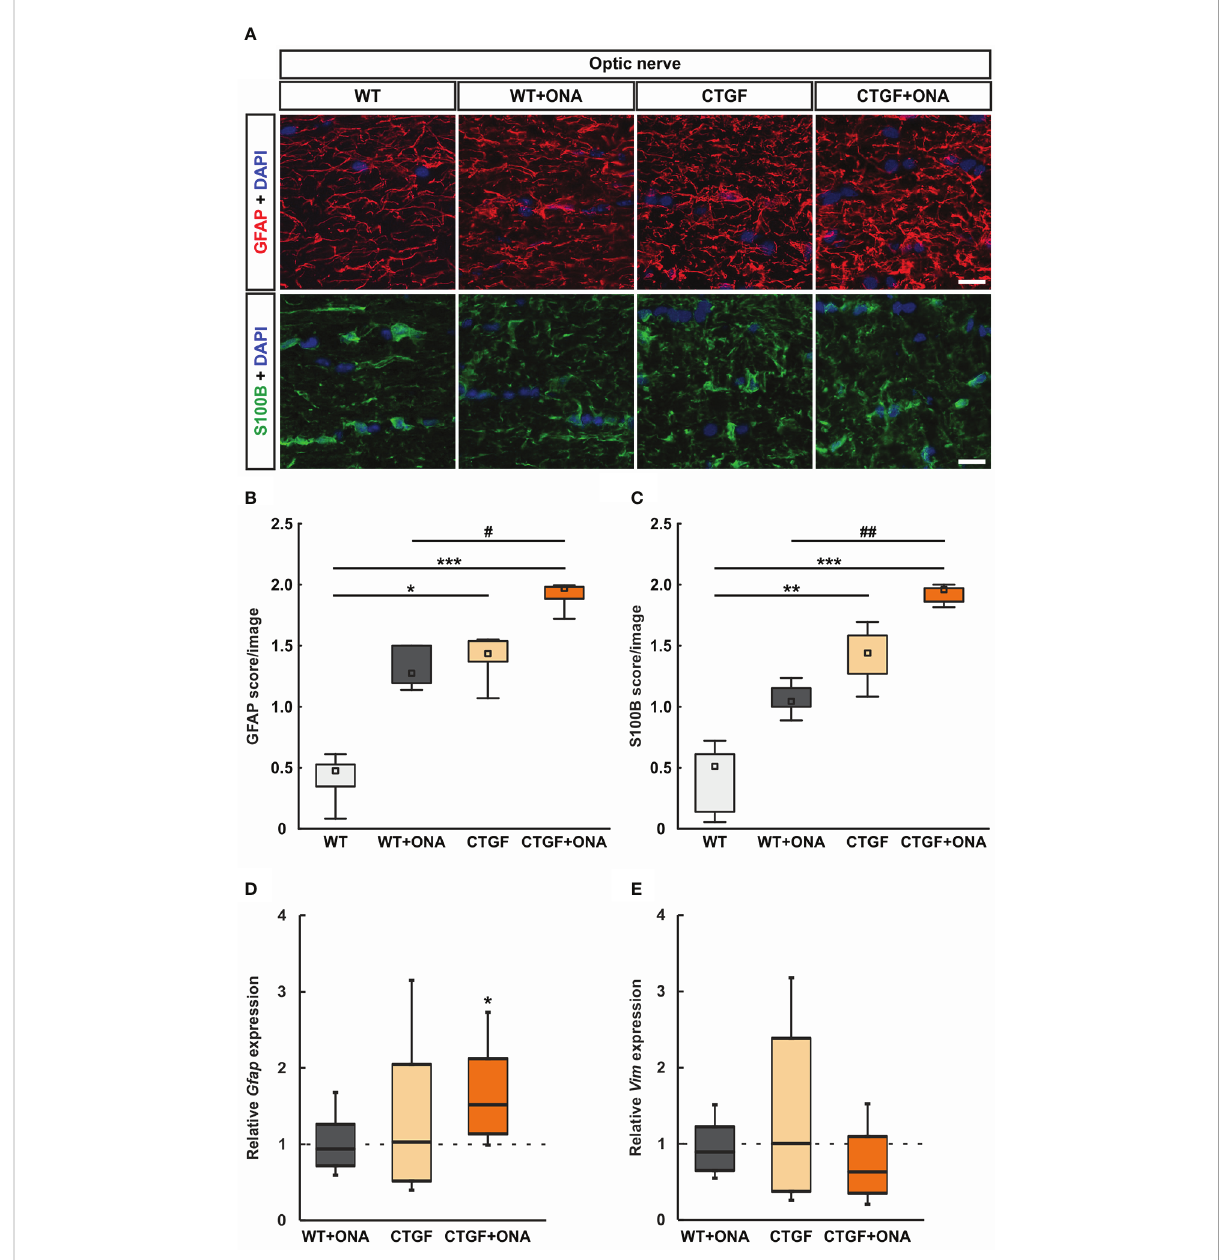
FIGURE 4 Increased astrogliosis in CTGF+ONA optic nerves. (A) Longitudinal optic nerve sections were stained with antibodies against anti-GFAP (red) and anti- S100B (green) to label astrocytes. DAPI was used to counterstain cell nuclei (blue). (B) The GFAP score was not altered in WT+ONA optic nerves compared to WT. A higher score was revealed in CTGF and CTGF+ONA optic nerves compared WT. The GFAP score in CTGF+ONA animals was also signi fi cantly higher than in WT+ONA mice. (C) In WT+ONA animals, the S100B score was not different when compared to WT optic nerves. A signi fi cantly higher S100B score was revealed in CTGF and CTGF+ONA optic nerves compared to WT. The S100B score of CTGF+ONA animals was signi fi cantly higher than in WT+ONA optic nerves. (D) The mRNA expression levels of Gfap were not altered in WT+ONA and CTGF mice. In contrast, a signi fi cant upregulation was noted in CTGF+ONA optic nerves. (E) The mRNA expression levels of Vim were similar in all groups. Values are median +/- interquartile range +/- range for histology and median ± quartile ± minimum/maximum for RT-qPCR. The dotted lines in (D, E) represent the relative expression of the WT group. *p<0.05, **p<0.01, and ***p<0.001 vs . WT; # p<0.05 and ## p<0.01 vs . WT+ONA. Scale bars: 20